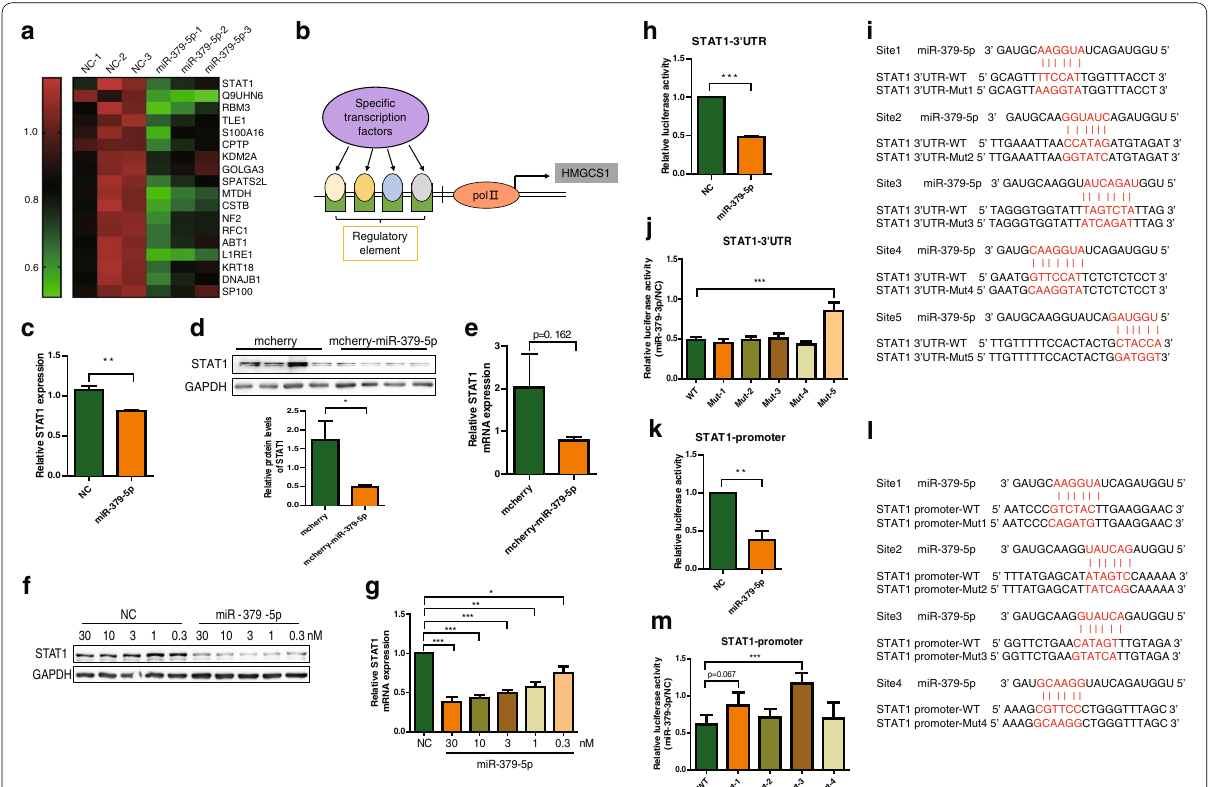
Fig. 5 Regulatory effect of miR-379-5p on STAT1. a Heatmap for 18 down-regulated proteins in the nucleus of miR-379-5p (30 nM)-treated Huh7 cells, compared to NC (30 nM)-treated Huh7 cells. b Schematic diagram of predicted transcription factors of HMGCS1. c Relative STAT1 protein level between miR-379-5p- and NC-transfected cells obtained from the data of MS. d & e STAT1 protein and mRNA levels in the livers of HFHC mice, n 7–8 in each group. f & g STAT1 mRNA and protein levels in Huh7 cells transfected with different concentrations of miR-379-5p mimics or NC for = 72 h. h STAT1 3’UTR activity in miR-379-5p (30 nM)- and NC (30 nM)-transfected HEK293 cells. i Five putative binding sequence between miR-379-5p and STAT1 3’UTR and their related mutants. j The activity of WT or mutants of STAT1 3’UTR in miR-379-5p (30 nM)- and NC (30 nM)-transfected HEK293 cells. k STAT1 promoter activity in miR-379-5p (30 nM)- and NC (30 nM)-transfected HEK293 cells. l Four putative binding sites between miR-379-5p and STAT1 promoter and their related mutants. m The activity of WT or mutants of STAT1 promoter in miR-379-5p (30 nM)- and NC (30 nM)-transfected HEK293 cells. For c, f and i, two-tailed student’s t-test was used to calculate statistical significance, while for d, h and k, One-Way ANOVA test was used. * p < 0.05, ** p < 0.01, *** p < 0.001, n 3 independent =